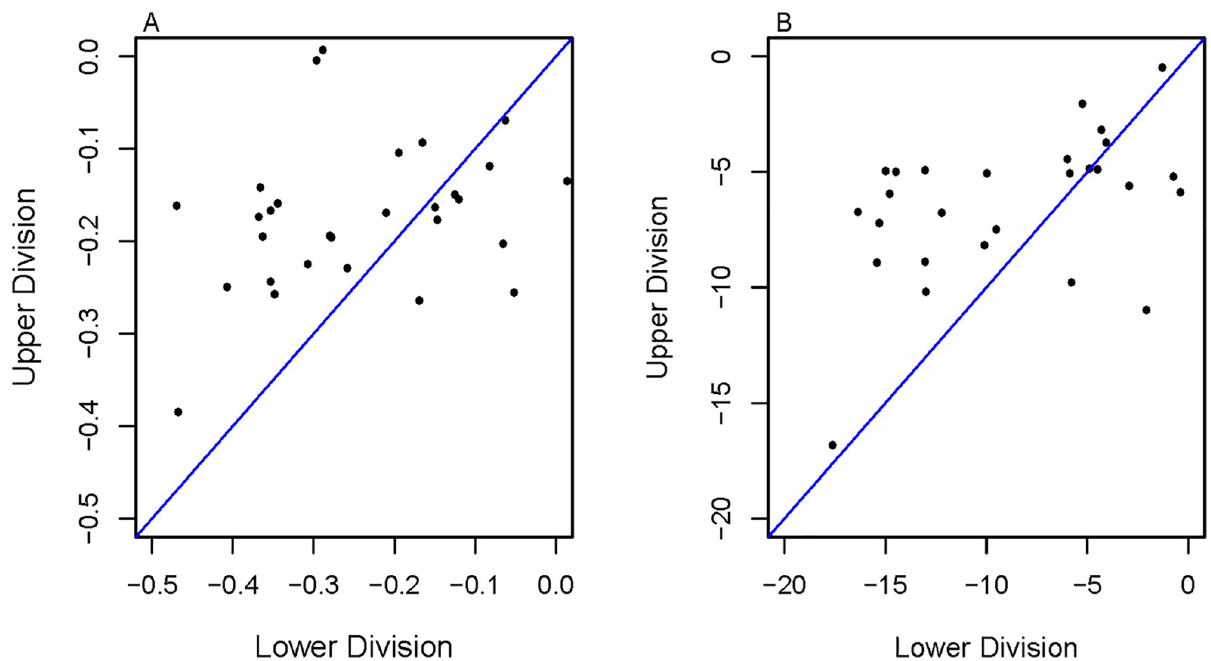
Fig 4. Scatterplots of the differences in grades given to PEERs and non-PEERs in lower and upper division courses at the department level. The plot on the left (A) is for department average Δ GP and on the right (B) is for department average Δ %AB. A total of 31 STEM departments had both lower-division and upper-division course sections and are included in the plots. The blue line ( y = x ) represents similarity in grades for lower and upper division courses (points above the line represent departments that have larger racial opportunity gaps in lower-division course sections).